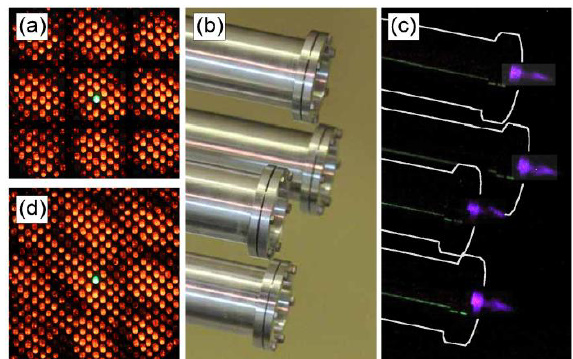
Fig. 3. DP of four-SR-BWO array reproduced at a single shot by a matrix neon-valve panel: in-phase operation (a); a frequen- cy shift in one channel (d); (b) – Four horns; (c) – Breakdowns of the air near vacuum windows